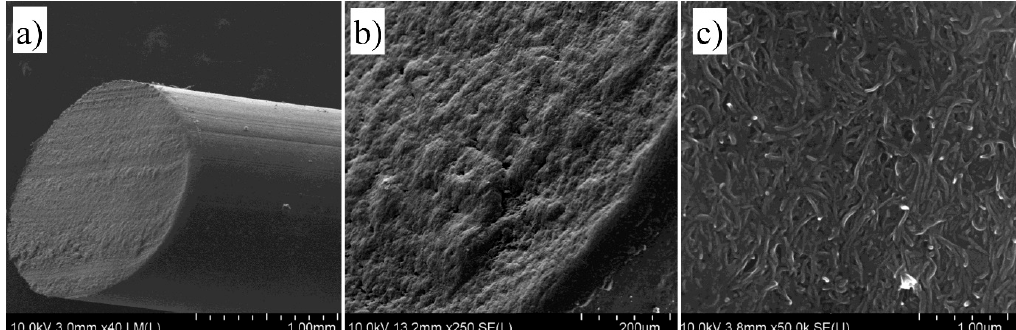
Figure 2. ( a – c ) Scanning electron microscope images of cross-section of CNT/TPU composite fiber performed at increasing magnifications.